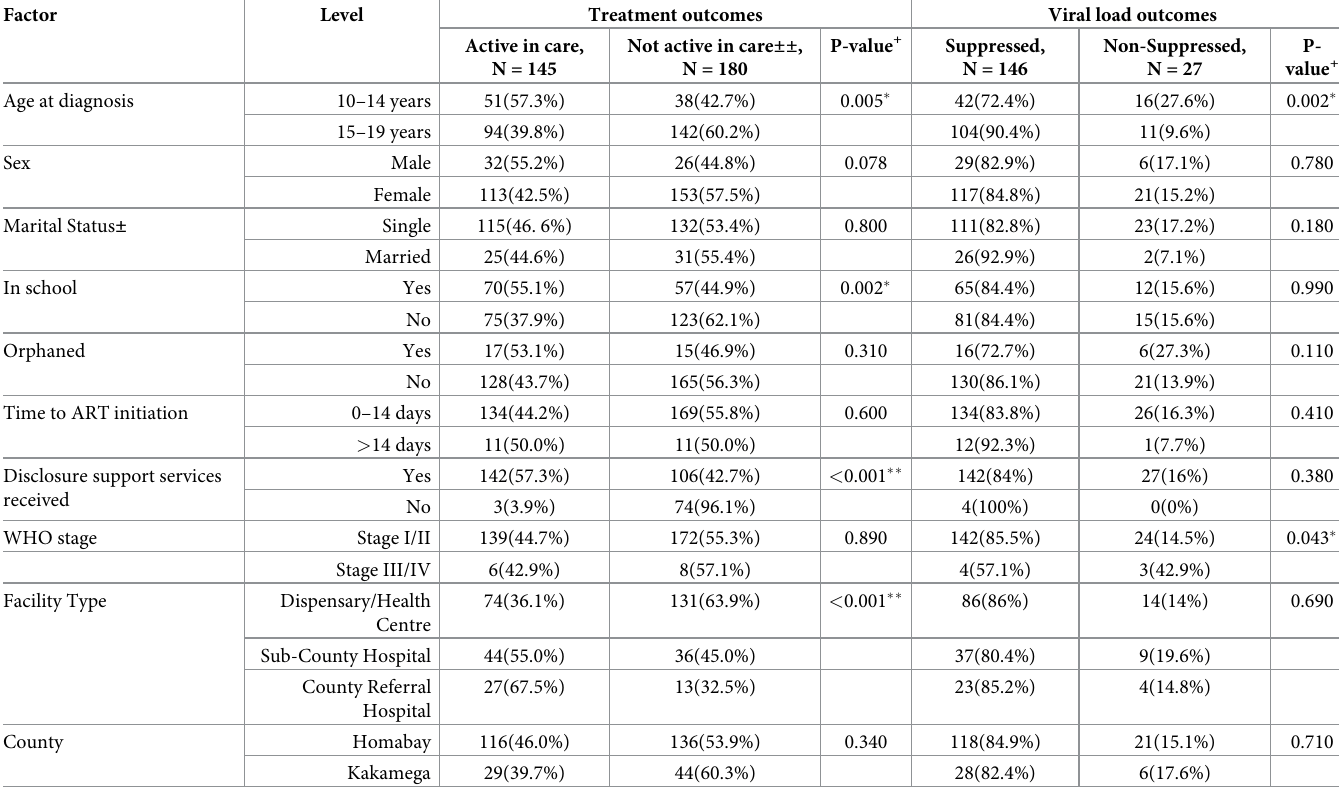
Table 2. Factors associated with treatment and viral load outcomes among ALHIV enrolled into HIV care between January 2017 and June 2018 in HCFs in Homa- bay and Kakamega